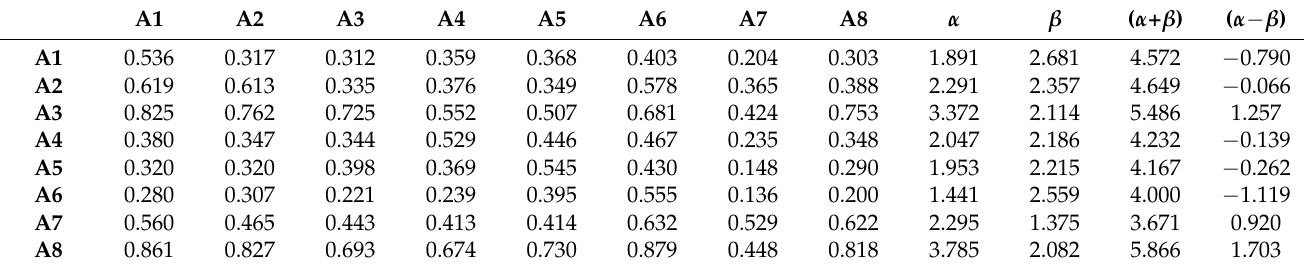
Table 6. Total interrelationship matrix and cause–effect interrelationships among aspects.